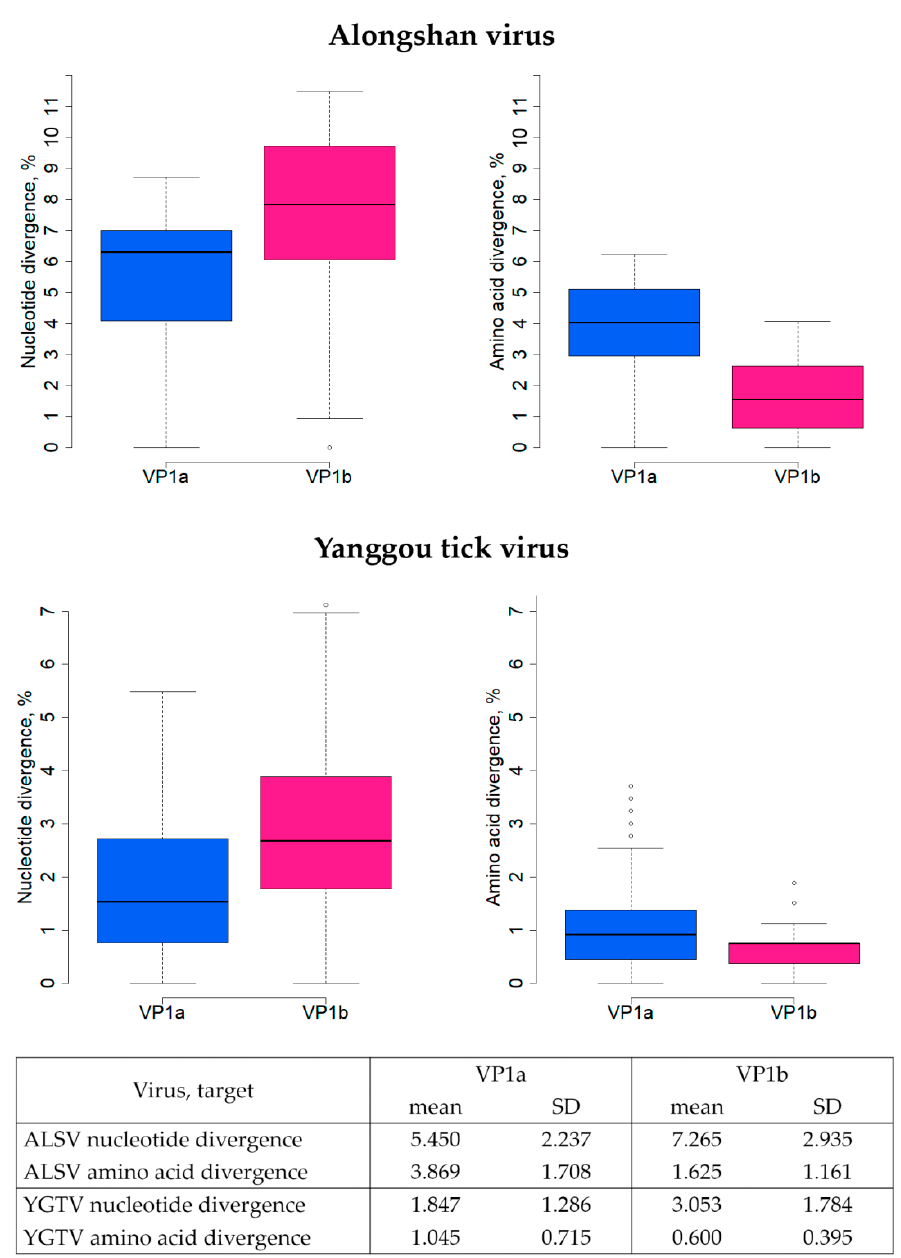
Figure 4. Estimates of evolutionary divergence between complete sequences of VP1a and VP1b proteins of the Yanggou tick virus and Alongshan virus. The table below represents mean and standard deviation (SD) of sequence divergences. The solid line represents the median, the box shows the interquartile range (IQR), and the whiskers represent 1.5 × IQR, the circles represent outliers (values exceeded 1.5 × IQR). Percentage identity of nucleotide and amino acid sequences of proteins VP1a and VP1b of each strain of the Yanggou tick virus and Alongshan virus were used to calculate the divergence (identity percentage) and are shown in Tables S4–S11. VP1a protein analysis includes 26 sequences of the Yanggou tick virus and 16 sequences of the Alongshan virus; VP1b protein analysis includes 16 sequences of the Yanggou tick virus and 16 sequences of the Alongshan